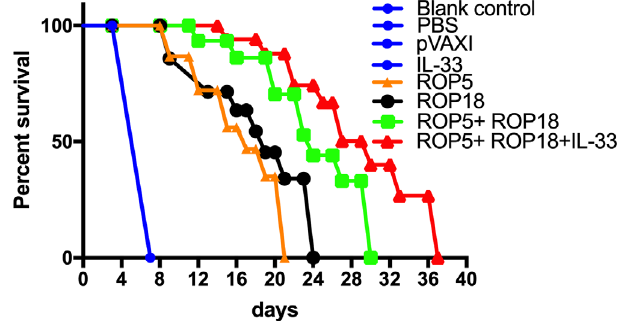
Figure 4. Protection against chronic toxoplasmosis in immunized mice two weeks after the last booster immunization. The bars represent the mean cyst burden per mouse brain after challenge orally with a dose of 10 cysts of the PRU strain. Cyst load was counted from whole brain homogenates of mice four weeks after challenge. Data are means ± SD (representative of three experi- ments). *** p < 0.001, compared with the control groups.